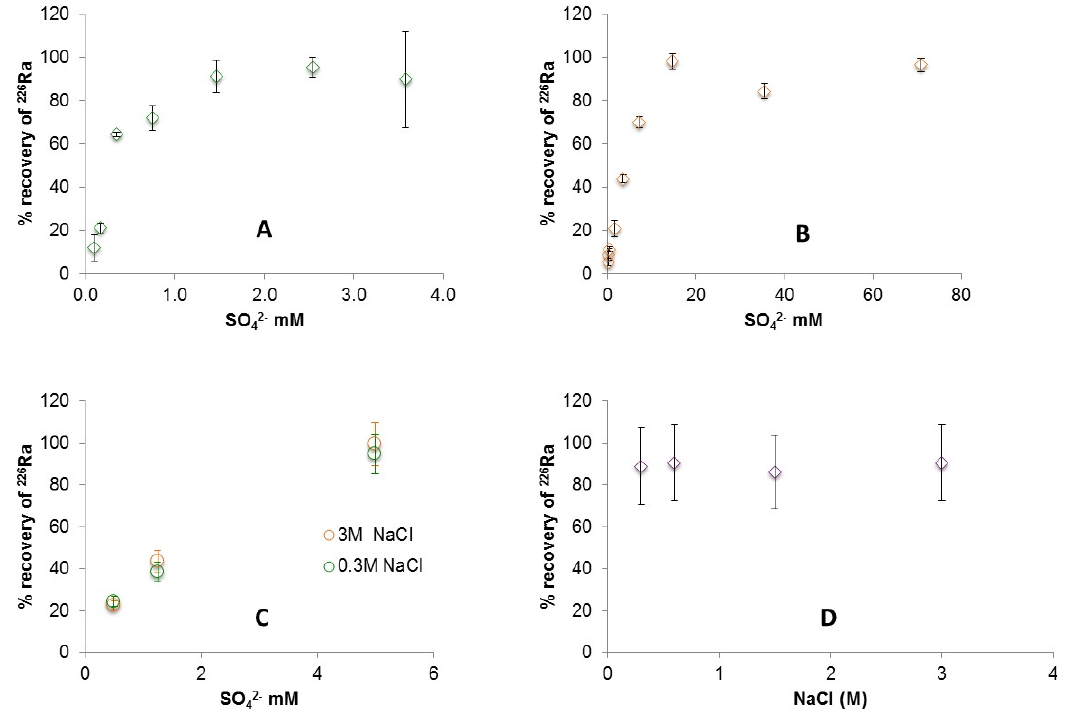
Figure 1. 226 Ra recovery by barite co-precipitation. ( A ) 0.3 M NaCl with 0.22 mM Ba 2 + and varying SO 42 − ; ( B ) 3 M NaCl with 0.22 mM Ba 2 + and varying SO 42 − ; ( C ) 0.3 and 3 M NaCl with 5 mM Ba 2 + and varying SO 4 2 − ; ( D ) 0.3, 0.6, 1.5 and 3 M NaCl with 20 mM Ba 2 + and SO 4 2 − .